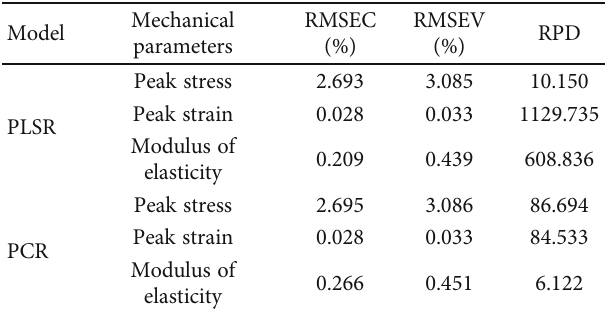
Figure 3: Correlation diagram between predicted values and measured values of PLSR and PCR prediction models for elastic modulus of frozen-thawed Table 2: Summary of PLSR and PCR model parameters of peak stress, peak strain, and elastic modulus of frozen-thawed rocks.